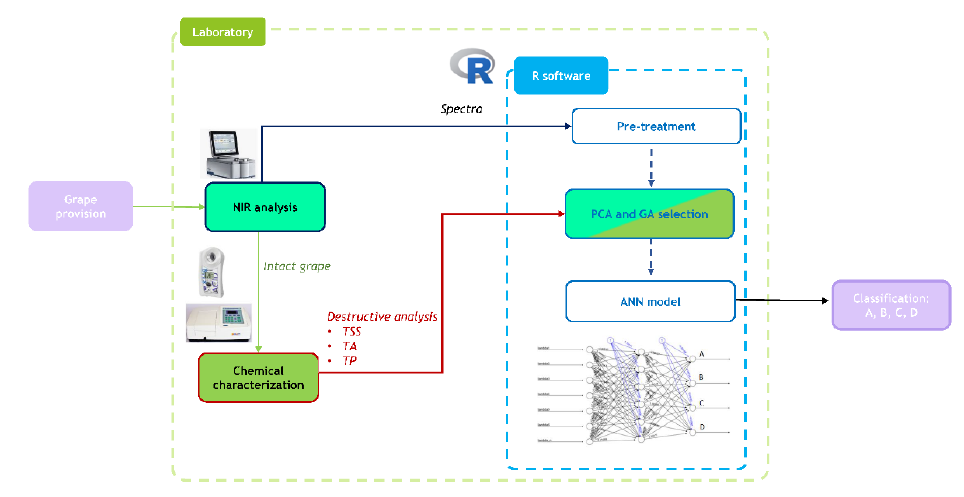
Figure 2. Process flow block diagram.